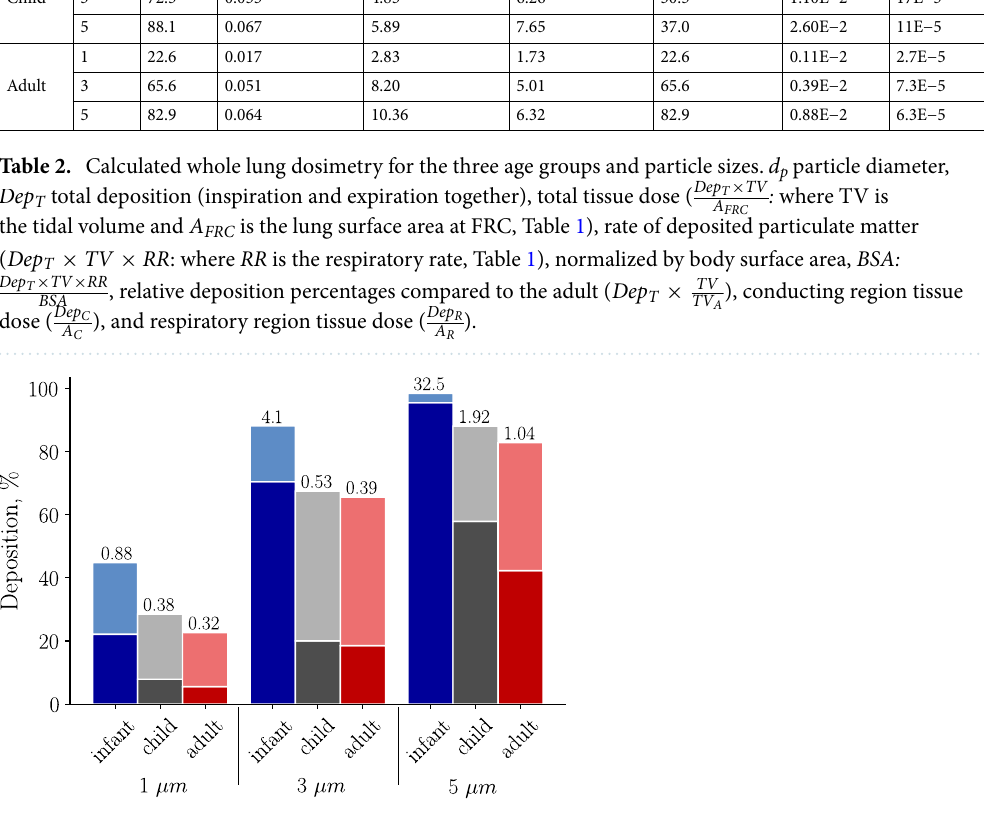
Figure 3. Whole lung deposition percentages for the three models are shown for each of the particle sizes simulated. Note, the conducting ( C ) and respiratory ( R ) zones are shown in dark and light shades, respectively. The ratio of deposited particles between the conducting and respiratory zones, CR ratio, are displayed above each bar. Figure 2 points to the conducting and respiratory zones. Note, the conducting zone includes both the 3D model and part of the 1D